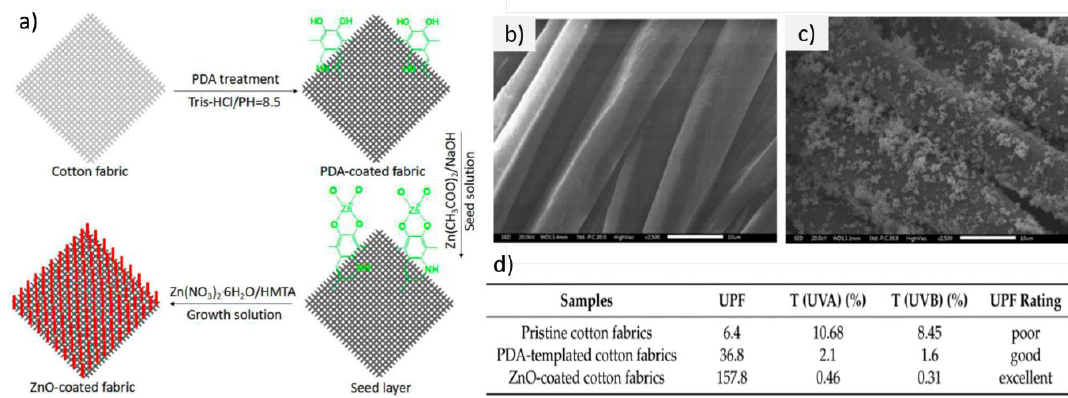
Figure 8. Schematics of the frowth of ZnO NPs on PDA-templated cotton fabric ( a ); surface morphology of pristine ( b ) and ZnO-coated ( c ) cotton fibres; UPF values, transmission (T) in the UVA and UVB regions, and UPF rating of the cotton fabric samples ( d ).